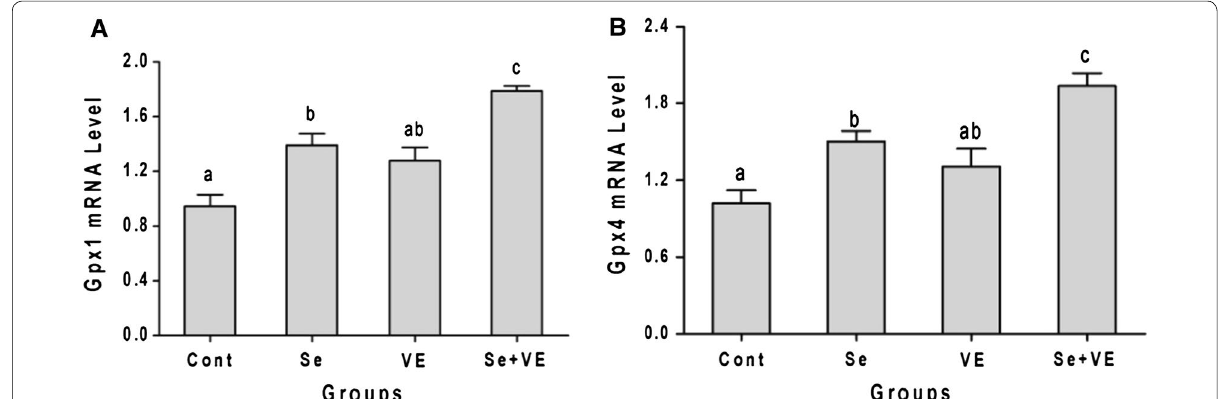
Fig. 3 Effects of Se, VE and Se VE on relative mRNA level of A Gpx1 and B Gpx4 in breast muscles of heat stressed broiler chickens. Mean values + with their standard errors. The values with unlike superscript letters (a, b, c) in the graph were different (P < 0.05)